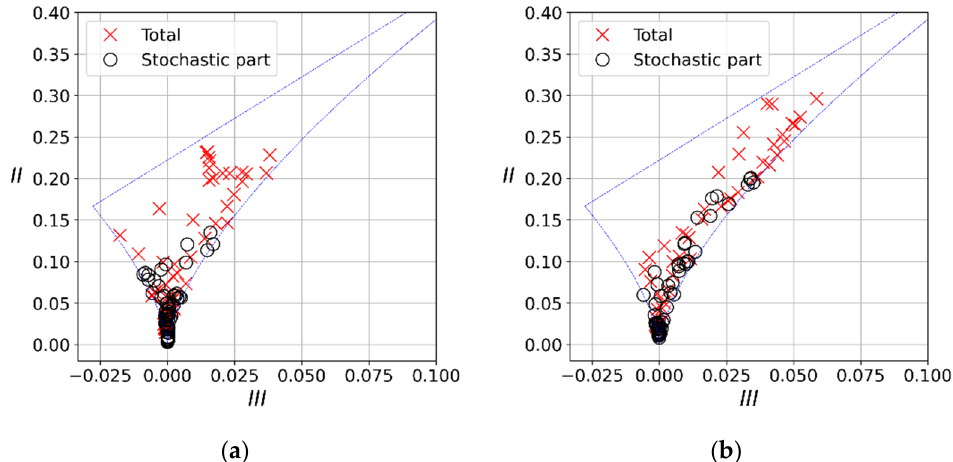
Figure 6. Turbulence anisotropy invariant map for ( a ) high-swirl jet (Re = 5000) and ( b ) gas turbine combustor (Re = 30,000).